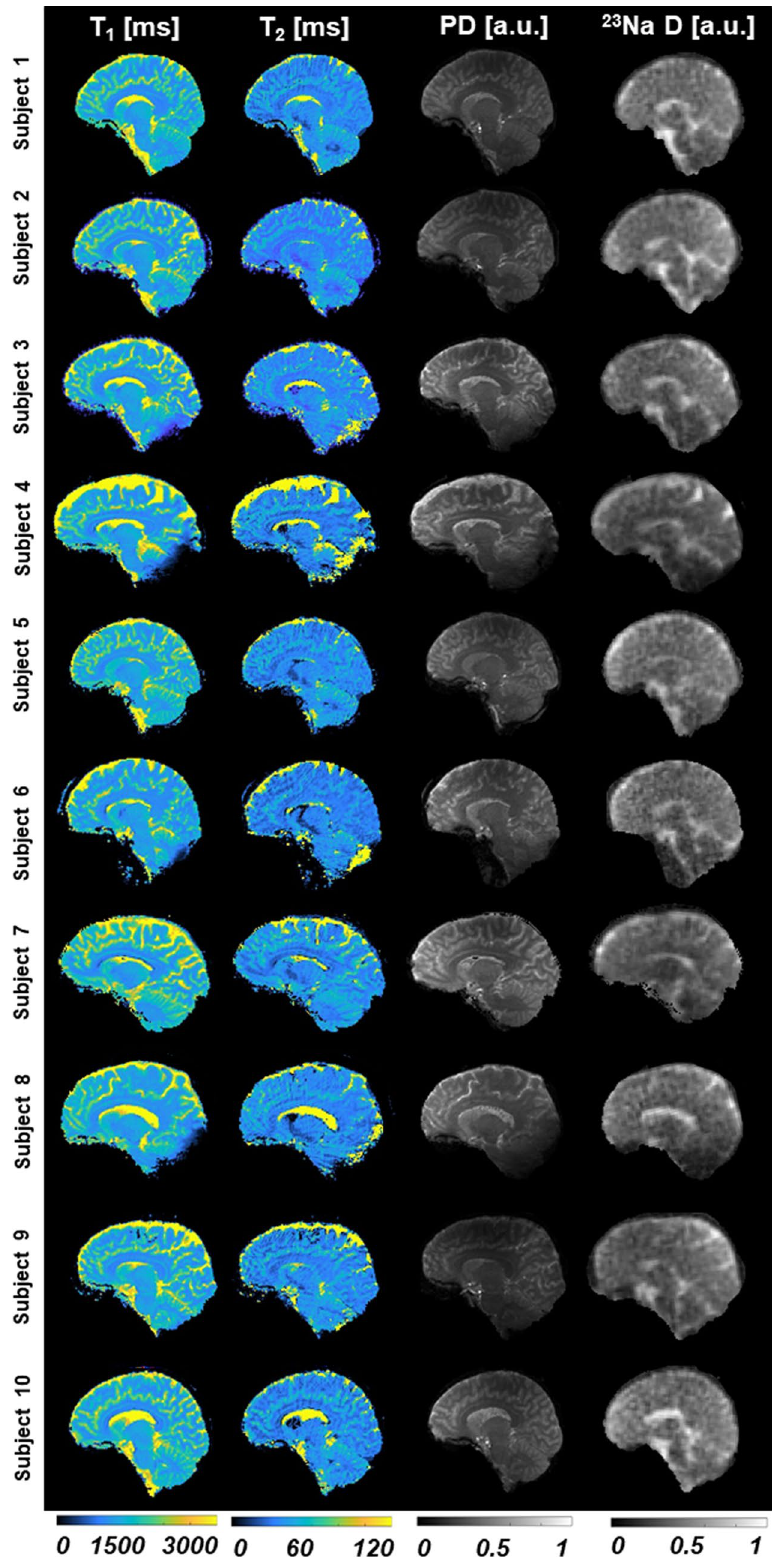
Figure 2. Maps from the first scan acquired in all the subjects (after co-registration, using subject 1 as reference) with simultaneous 1 H MRF/ 23 Na MRI. The in-plane resolution is 1.5 × 1.5 mm 2 for the proton images and 2.85 × 2.85 mm 2 for the sodium image. Slice thickness is 3 mm for both nuclei. PD is normalized proton density and 23 Na D is normalized sodium